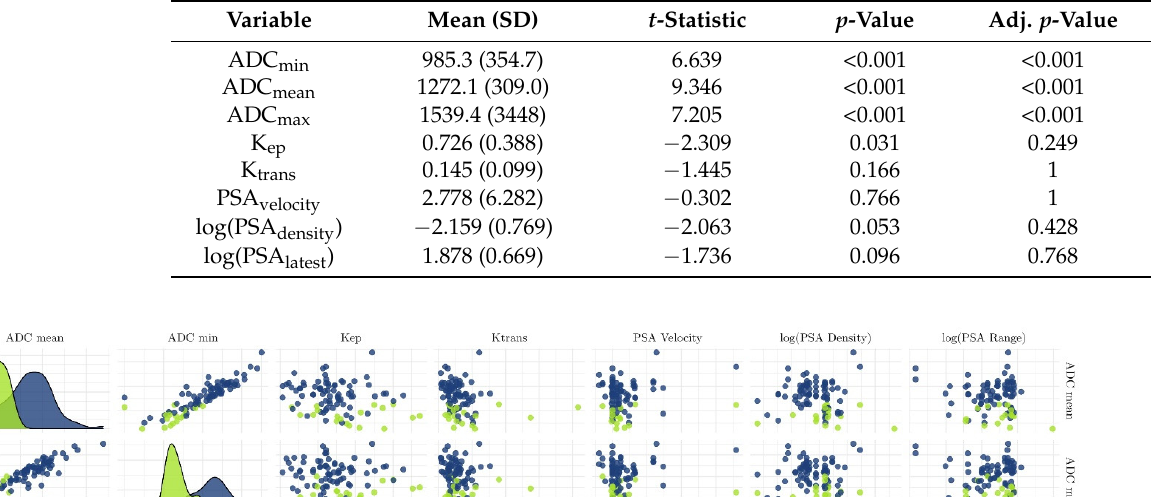
Table 4. Clinical and imaging parameters to discriminate csPCa and non-csPCa/no tumor.